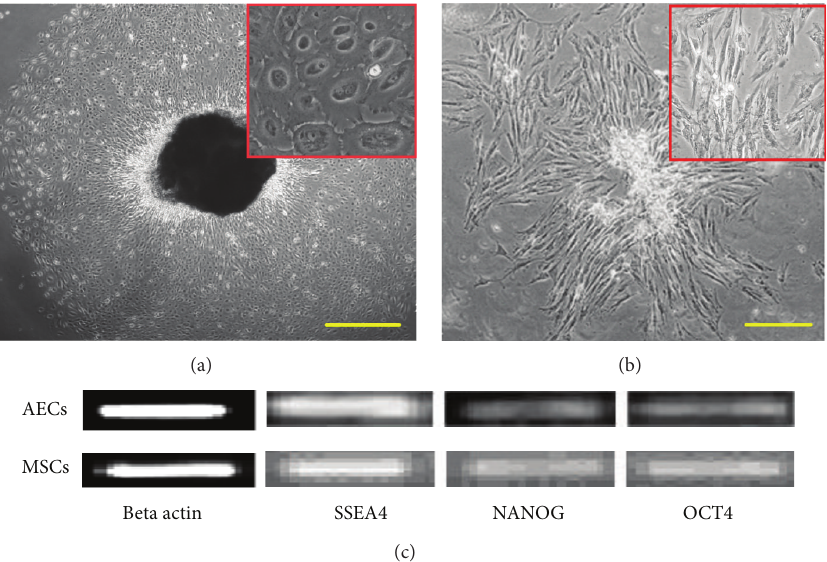
Figure1:Morphologicalappearanceofhumanamnioticepithelialcells (AECs)andumbilicalcordmesenchymalstemcells(UC-MSCs).Cells in the primary culture of AECs (a) and UC-MSCs (b). AECs displayed rounded shape while UC-MSCs showed spindle shaped morphology. Insets show morphological features at higher magnification. Both types of cells showed expression of embryonic lineage markers SSEA4, NANOG, and OCT4 (c). AECs: amniotic epithelial cells, UC-MSCs: mesenchymal stem cells, SSEA4: stage specific embryonic antigen 4, and OCT4: octamer binding protein 4.